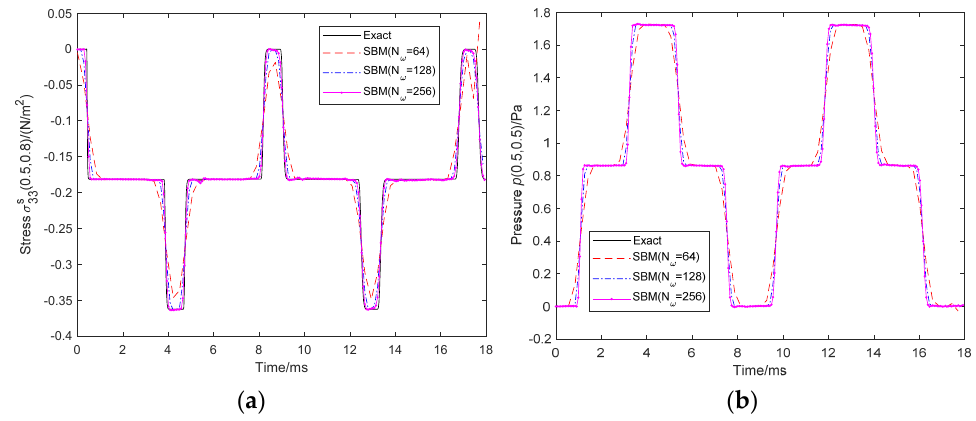
s σ at (0.5, 0.8) and ( b ) p at (0.5, 0.5) with respect to the number of Figure 3. Time history of ( a ) Figure 3. Time history of ( a ) σ s at (0.5, 0.8) and ( b ) p at (0.5, 0.5) with respect to the number of 33 33 sampling frequencies N ω . sampling frequencies N ω